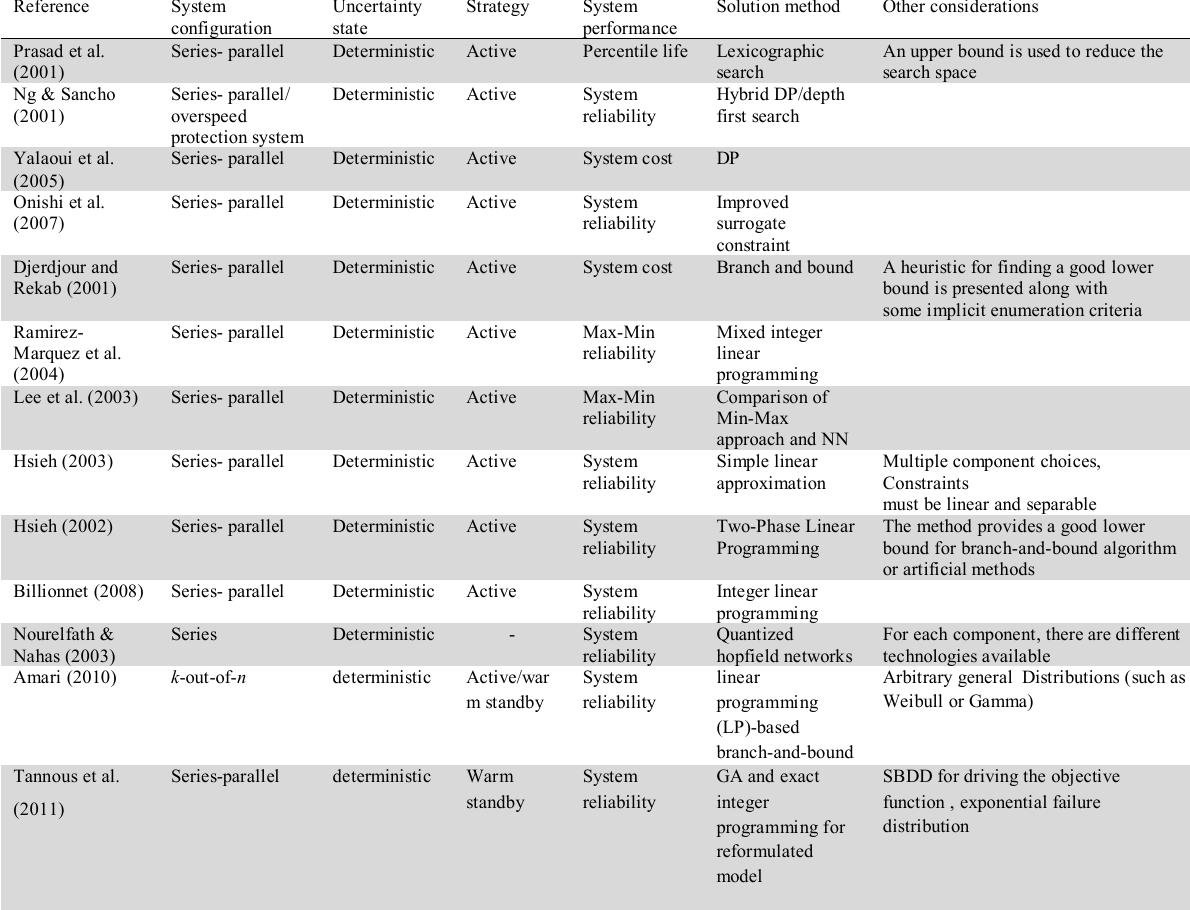
Exact and Mathematical programming approaches for RAP (Single Objective Problems)